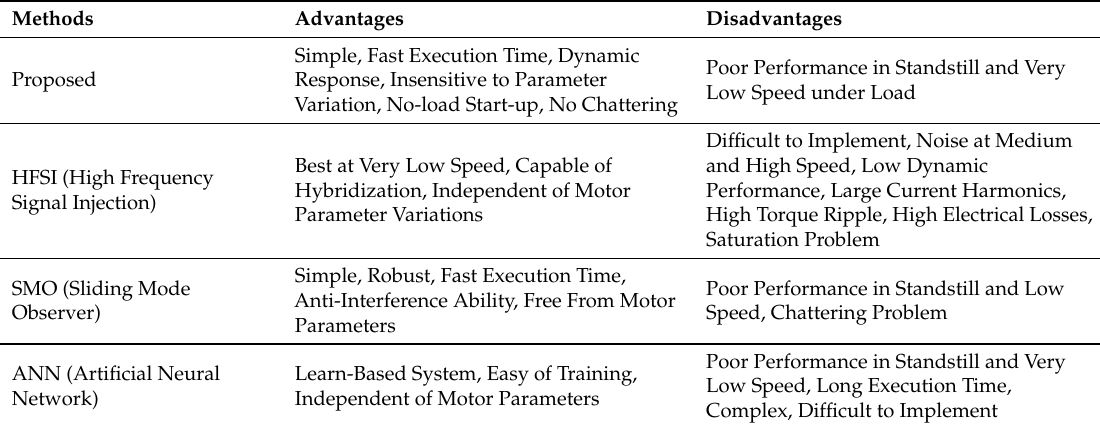
Table 1. Comparison of the proposed and existing sensorless methods.